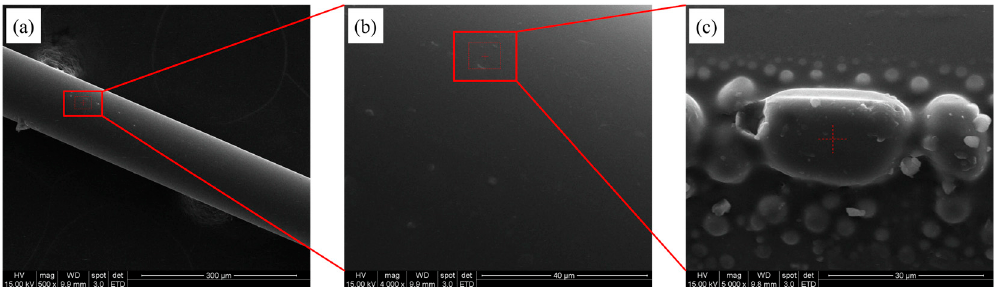
Figure 4. SEM images of the surfaces of the self-assembled layers of the optical fiber at ( a ) 500 times magnification; ( b ) 4000 times magnification; ( c ) 5000 times magnification with 3-MPA magnifica- tion.